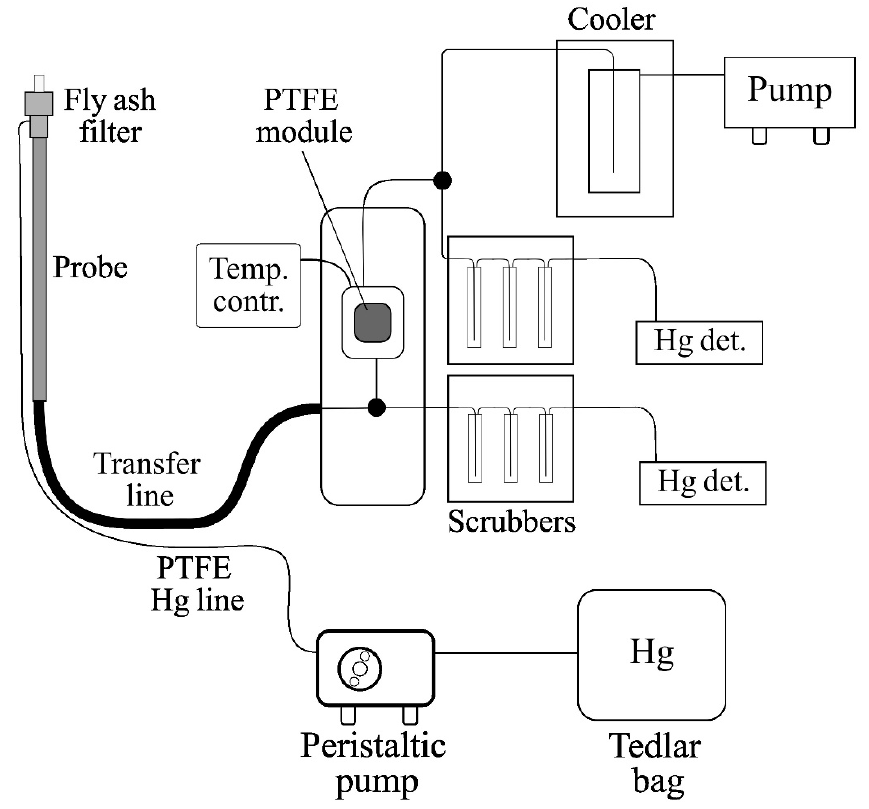
Figure 4. The industrial stand for preliminary testing of FSM.